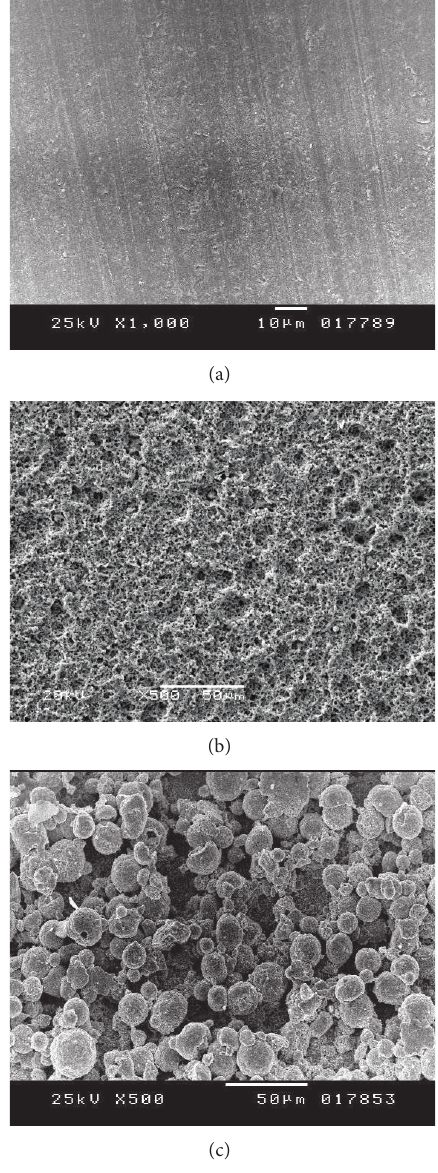
Figure 2: (a) SEM image, 1000x, demonstrating dense nonretentive as-sintered surface zirconia. (b) SEM image, 1000x, of selective infiltration etched zirconia surface with characteristic nanoporous surface. (c) SEM image, 500x, of fusion sputtered zirconia surface with characteristic fused beads on the